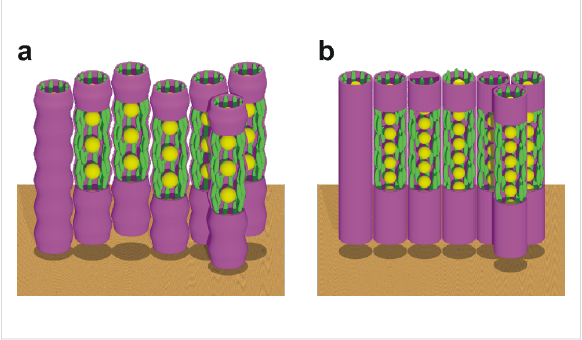
Figure 16: Schematic representation of the gold NP columnar struc- tures. (a) Rhombohedral phase in Au@C 12 /13 and (b) hexagonal columnar phase in Au@C 6 /13 . Gold NPs = yellow, ligands = green. Reprinted with permission from [65]. Copyright 2009 Wiley-VCH